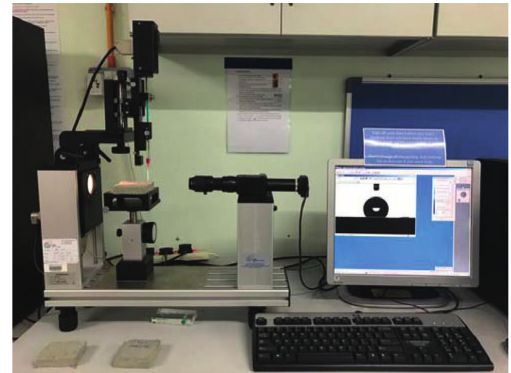
Figure 3: OCA 15EC with software SCA 20 module.